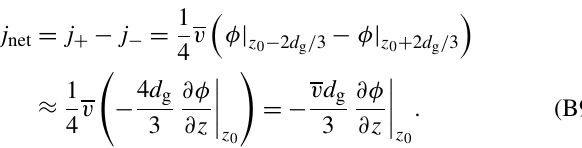
Figure B2. Diffusivity κ at different temperatures, calculated with Eq. (9) for c 1 = 2 .